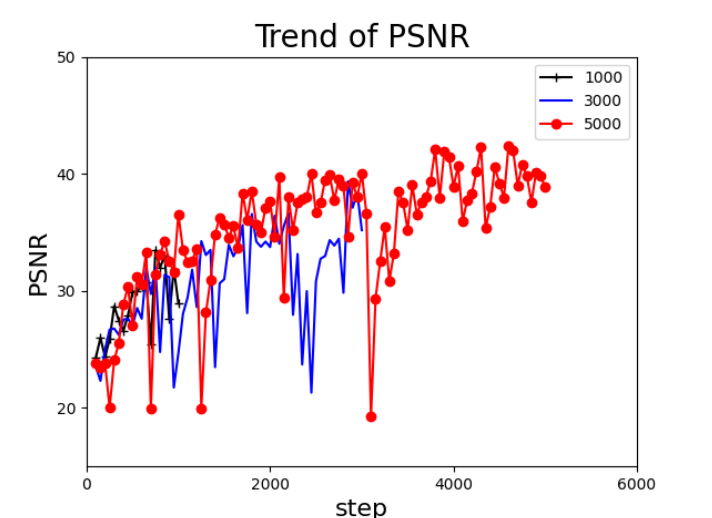
Figure 8. Graph showing the results of the PSNR trend when only the training duration is changed. The peak at 3000 steps is close to that at 5000 steps, and there is a significant drop in the peak value when the step is reduced to